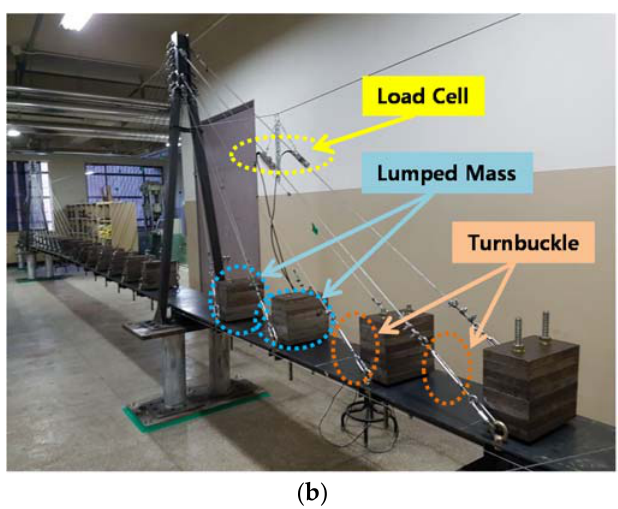
Figure 8. Model bridge: ( a ) Design of model bridge; ( b ) product of model bridge.